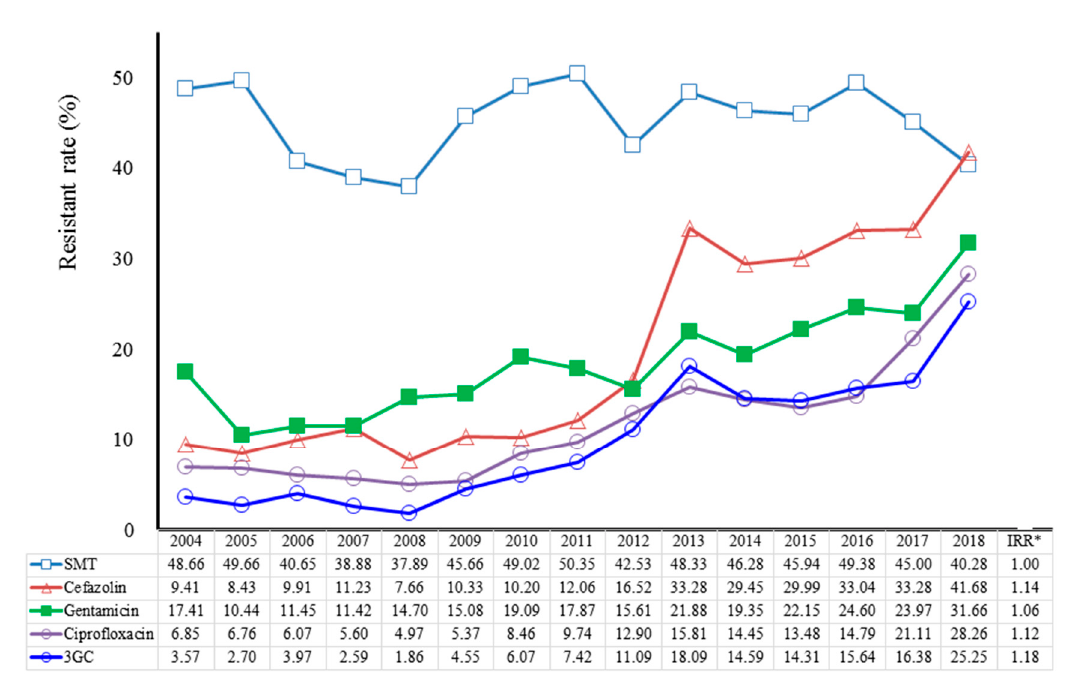
Figure 3. Trends of antibiotic resistance of community-associated E. coli UTI (single isolate) among children aged < 18 years, 2004–2018. SMT, sulfamethoxazole–trimethoprim; 3GCs, third-generation